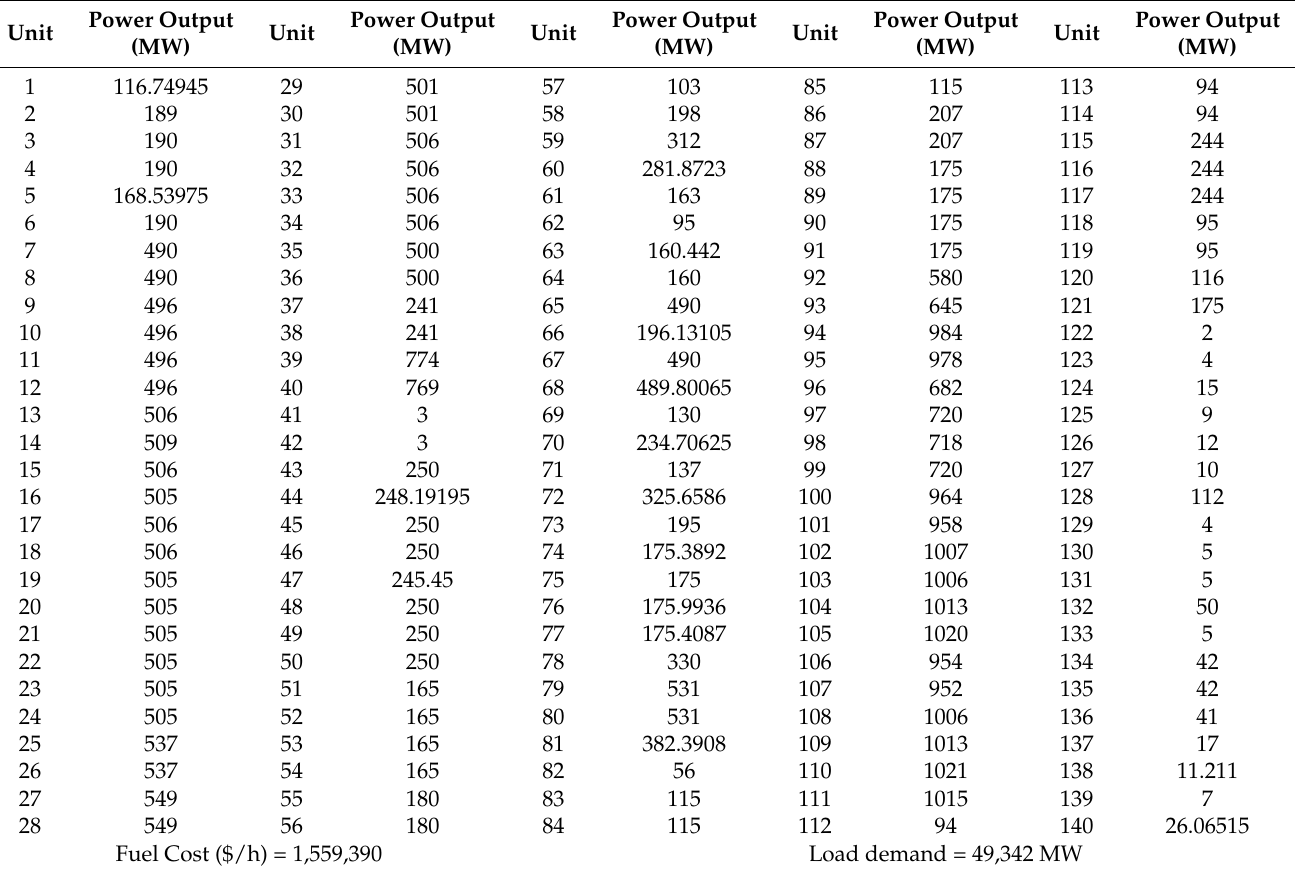
Figure 10. Comparative convergence characteristic of original GWO and proposed RLGWO algo ‐ rithm for the 140 ‐ unit system.